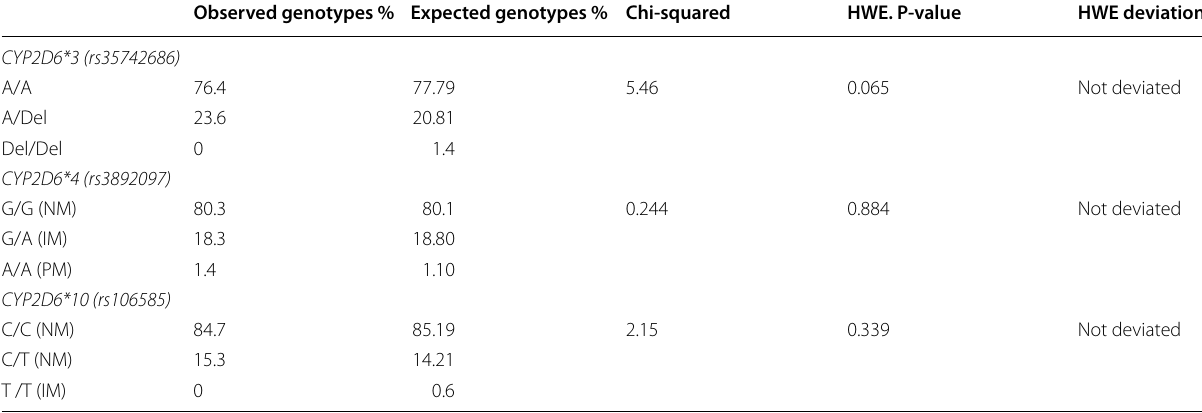
Table 2 Hardy–Weinberg Equilibrium for CYP2D6 polymorphisms in the Moroccan population Observed genotypes % Expected genotypes % Chi-squared HWE. P-value